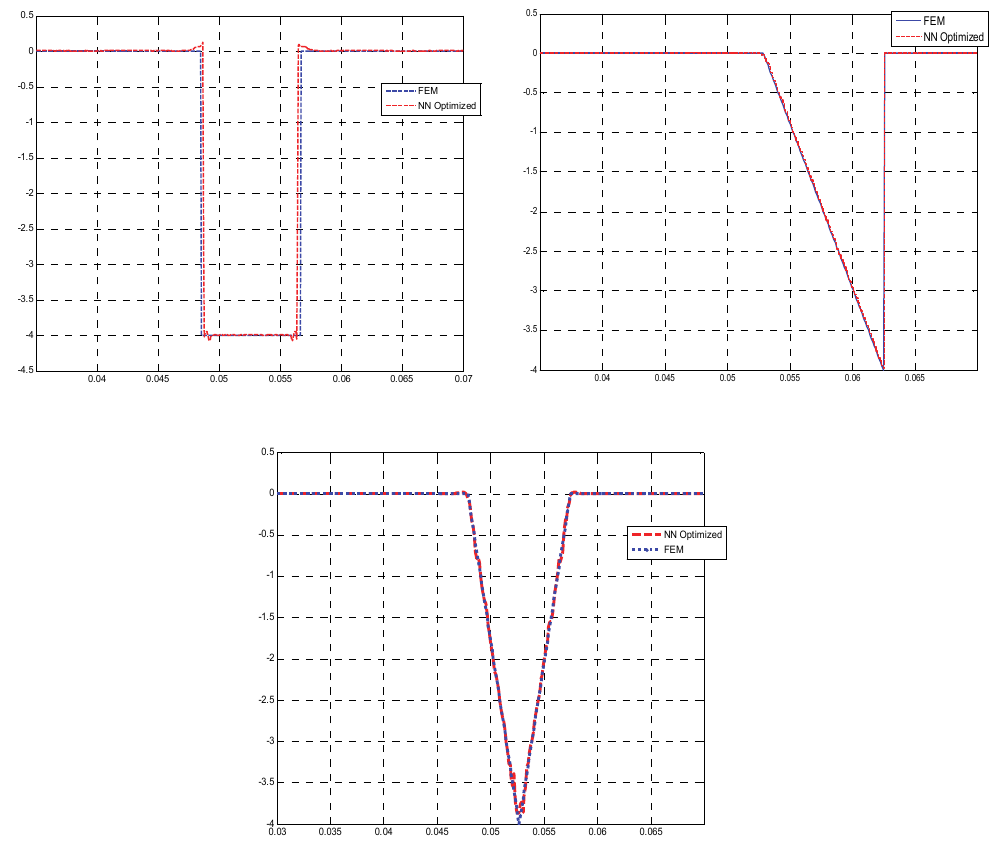
Figure 10: Comparison results from the NN Optimized, FEM